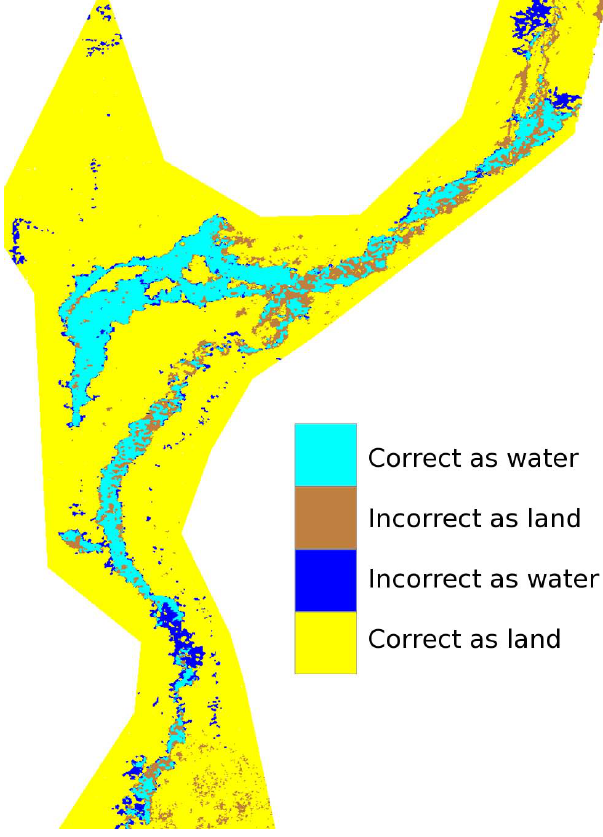
Fig. 20. Comparison of the 1σ 0 -derived flood map on from 29 Au- gust 2010 against MODIS flood